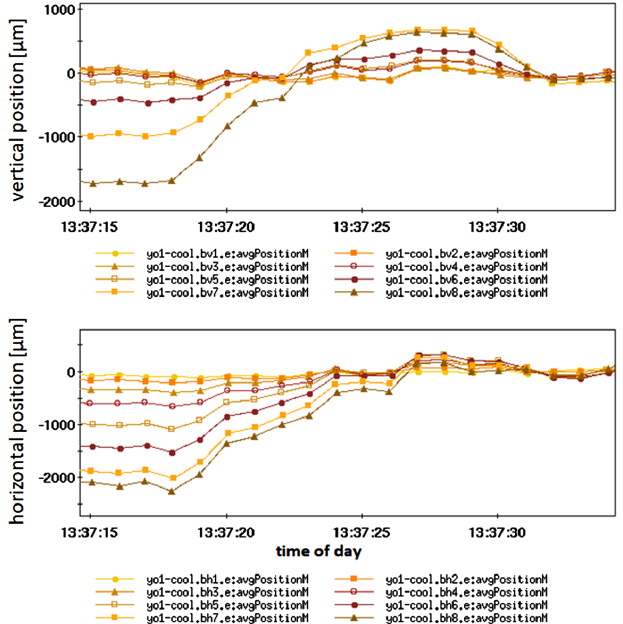
FIG. 6. Horizontal (bottom plot) and vertical (top plot) position of the electron beam measured by BPMs along the Yellow CS during application of the trajectory correction